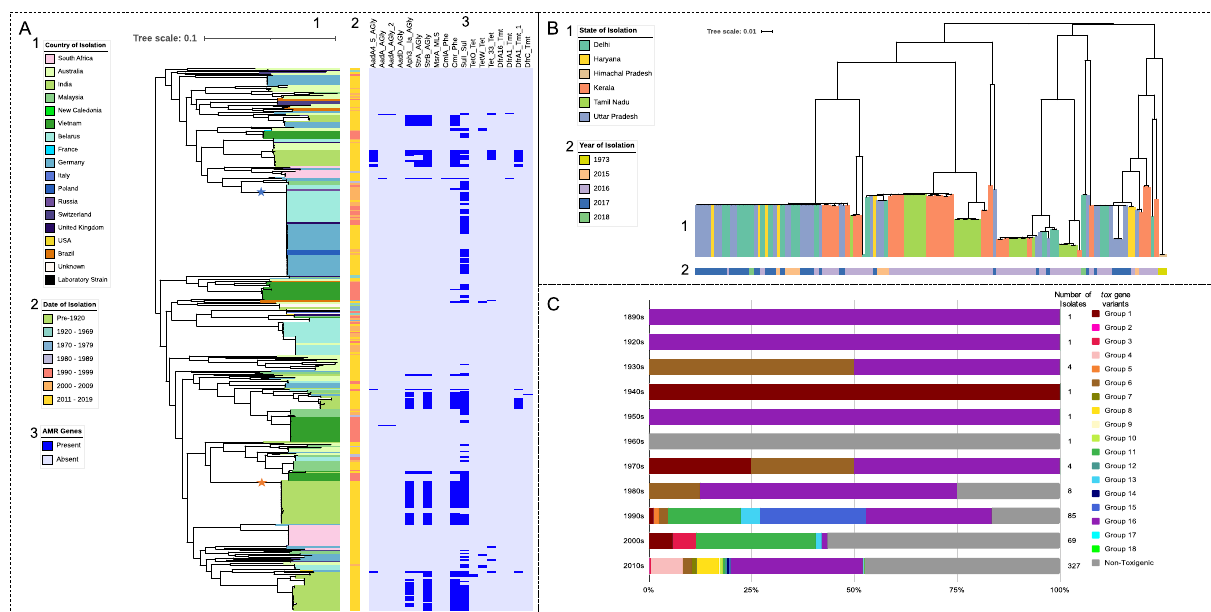
Fig. 1 Global and Indian core gene phylogenies of Corynebacterium diphtheriae and tox gene variants by decade. A Maximum likelihood phylogenetic tree based on the core gene single nucleotide polymorphisms from the 502 global Corynebacterium diphtheriae genome collection. The country of isolation (1), decade of isolation (2), and AMR gene presence/absence heatmap made using ARIBA 50 (3), are all annotated. Most monophyletic groups within the tree represent only one country and decade, with the major exception of the large Belarussian/German dominated group, marked with a blue star. Both the blue and orange stars highlight groups used for BEAST analysis. B The core gene maximum likelihood phylogeny of only the 122 Indian isolates, coloured by state (1) and year of isolation (2). C The proportion of the 18 tox gene variants found across 291 tox + and 211 non-toxigenic isolates per decade, with the number of isolates per decade